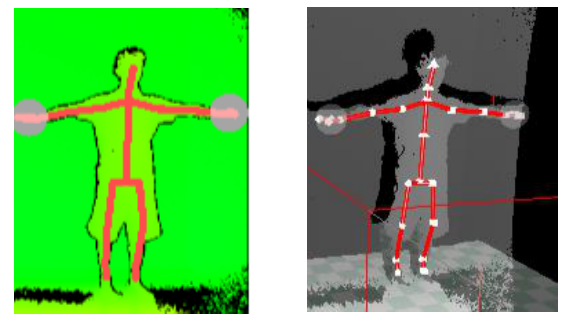
Figure 10. T – Pose in Kinect Studio, in Playback 3D view (left) and in Playback 2D view (right)